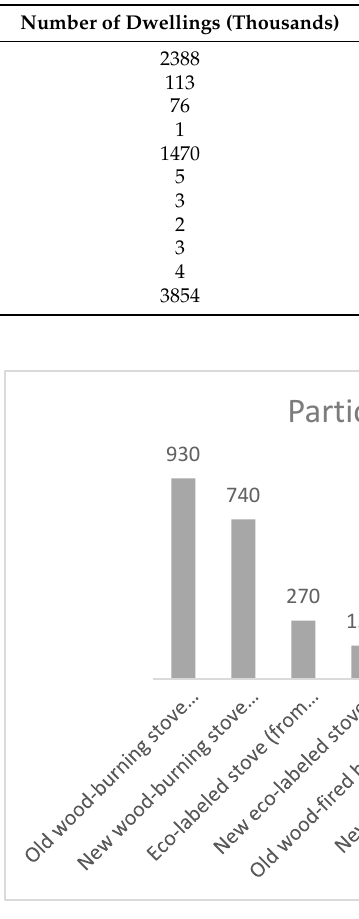
Figure 1. Particulate emissions of different heating methods in Denmark [1].